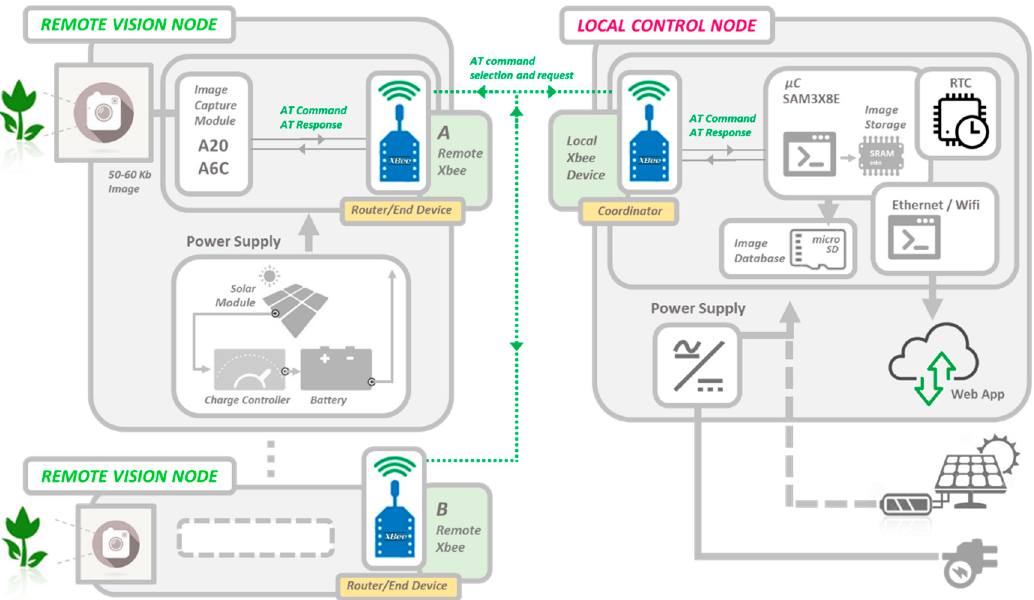
Figure 1. Global view of the proposed system. The main components are the in-field remote vision nodes, the local control node web, the web server and the remote clients.